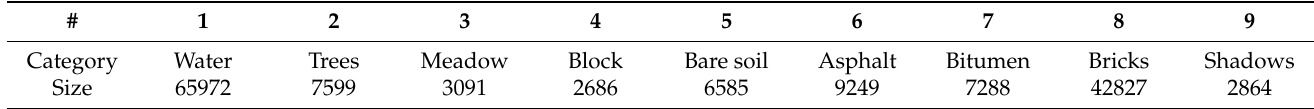
Figure 3. False-color composite map of Pavia Center and ground truth information: ( a ) False-color composite image; ( b ) Ground truth image. Table 2. Land category and sample size of Pavia Center data set.